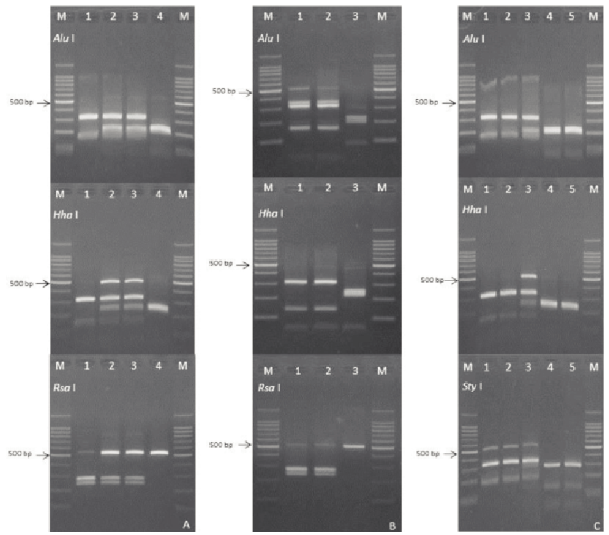
Fig. 3 ­ PCR­RFLP profile of parents and progenies. A: HRA × RCO. 1. HRA, 2. WXO1, 3.WXO2, 4. RCO. B: HRA × RCP. 1. HRA, 2. WXP, 3. RCP. C: HRA × RCY. 1. HRA, 2. WXY1, 3.WXY2, 4.YXW, 5.